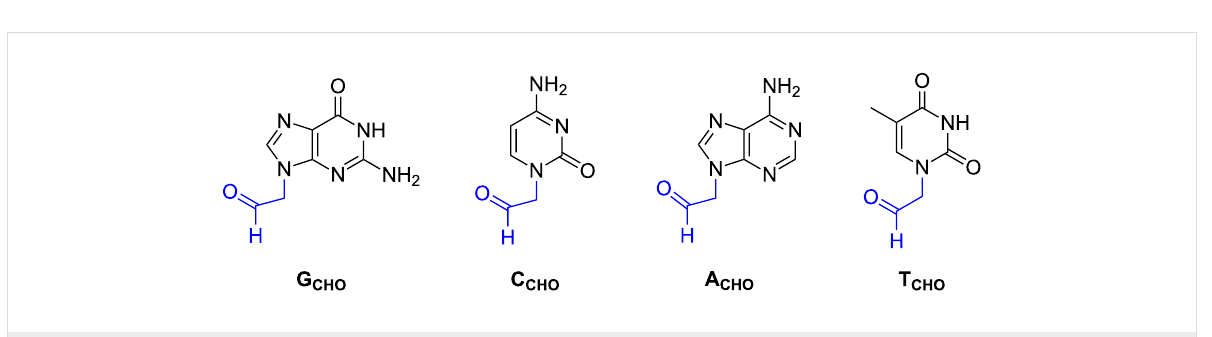
isolation and analysis of the library derived from oligonucleo- tide ON1 . Anion exchange high-performance chromatography was used for the analysis of the final reaction mixture. The reac- tion mixtures were composed of six oligonucleotides: the unre- acted initial strand ON1 , one of its complementary strands T C , T G , T T or T A and the four possible product strands ON1+G , ON1+C , ON1+A , ON1+T (Figure 4). HPLC separation of the four possible products in the same reaction mixture was chal- lenging because the lengths of the starting sequence CGCTAT X TATCGC ( ON1 ) and the product sequences ( ON1+G , ON1+C , ON1+A , ON1+T ) were identical differing only by one nucleobase in the central position X . As shown in